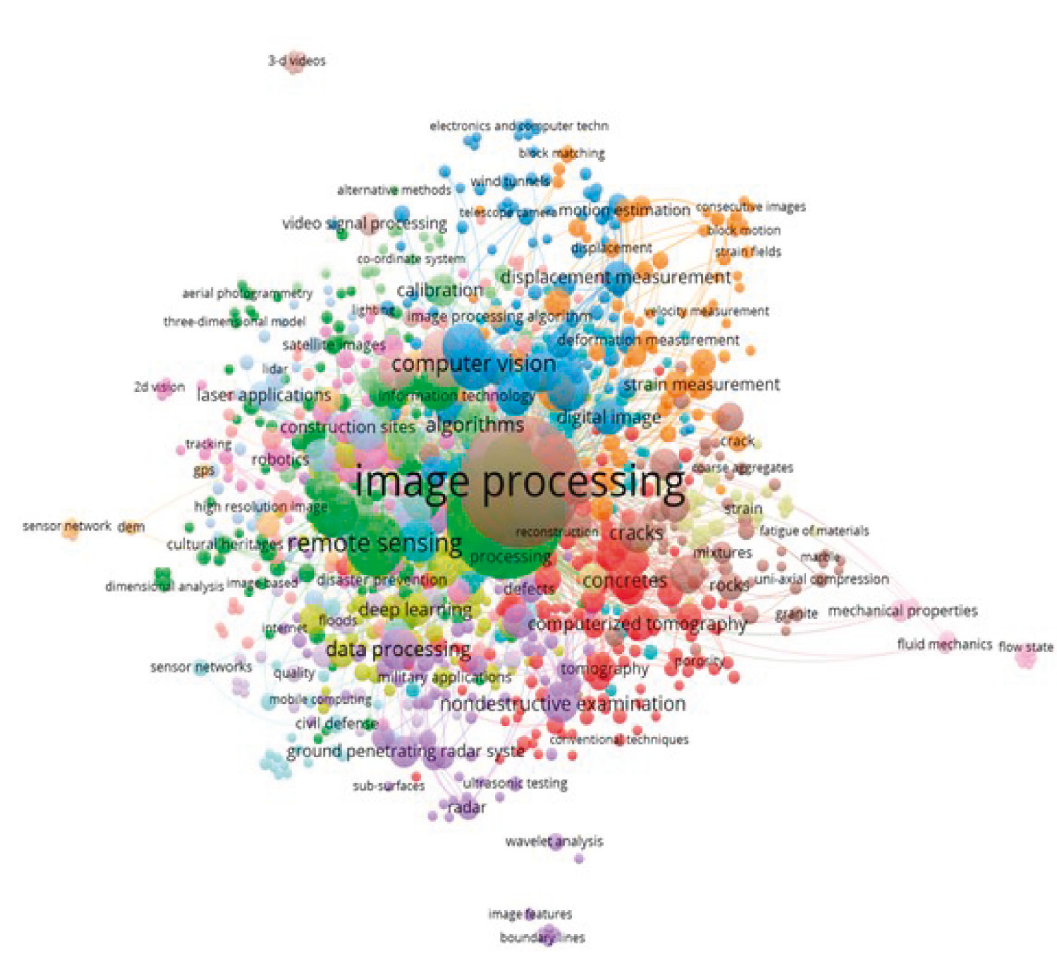
Figure 14: Network of keyword